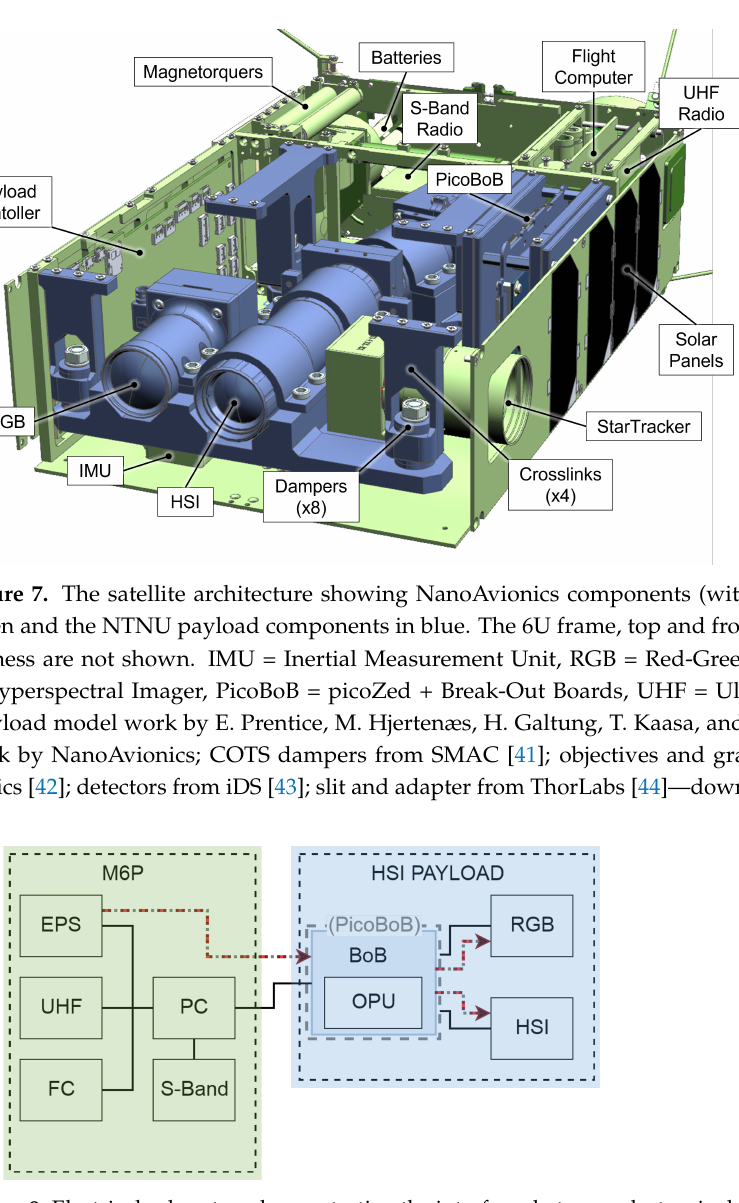
Figure 8. Electrical subsystem demonstrating the interfaces between electronics boards on the satellite: red/grey dotted arrows indicate power; black lines are data links. NanoAvionics is responsible for the M6P platform, NTNU for the HSI payload. Abbreviation key: M6P = satellite bus platform, EPS = Electronic Power Supply, UHF = Ultra-High Frequency radio, FC = Flight Computer, PC = Payload Controller, S-band = radio, BoB = Break-out Board, OPU = On-board Processing Unit, RGB = Red- Green-Blue imager, and HSI = Hyperspectral